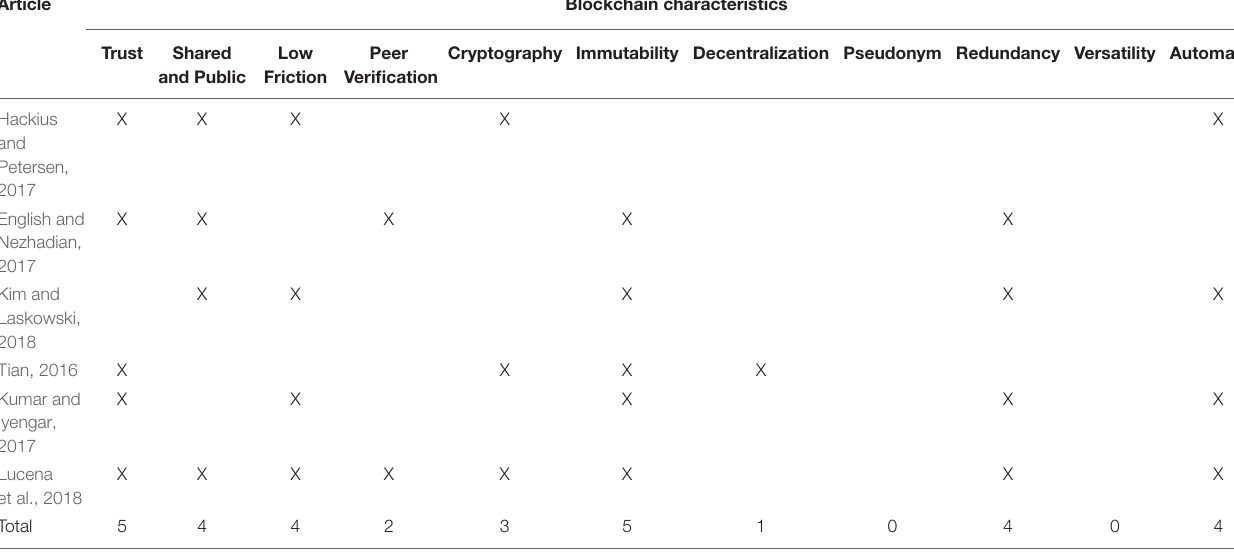
TABLE 2 | Article classification against blockchain